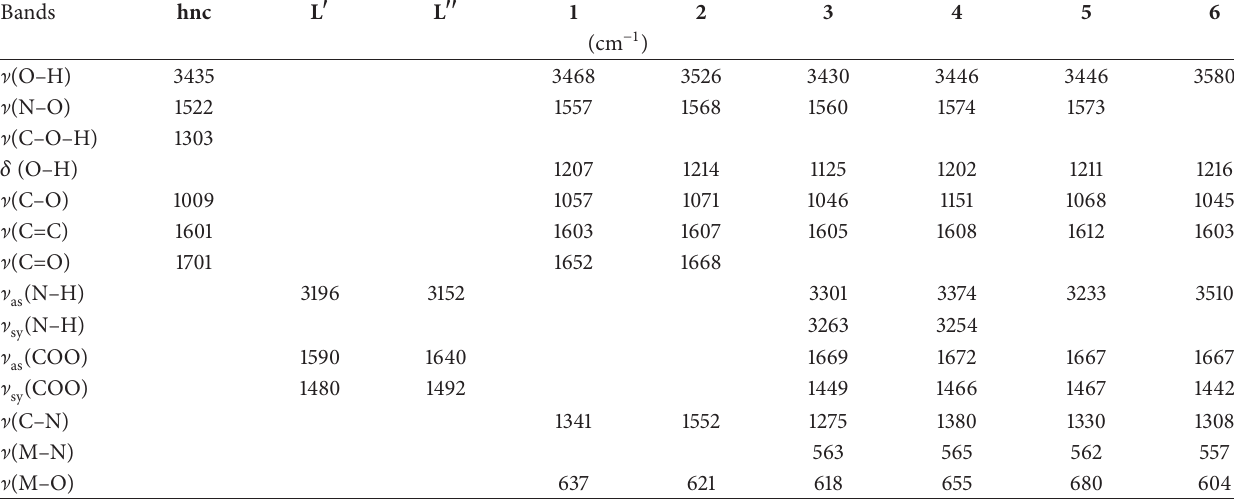
Table 1: Relevant infrared spectra bands for the ligands and complexes (cm −1